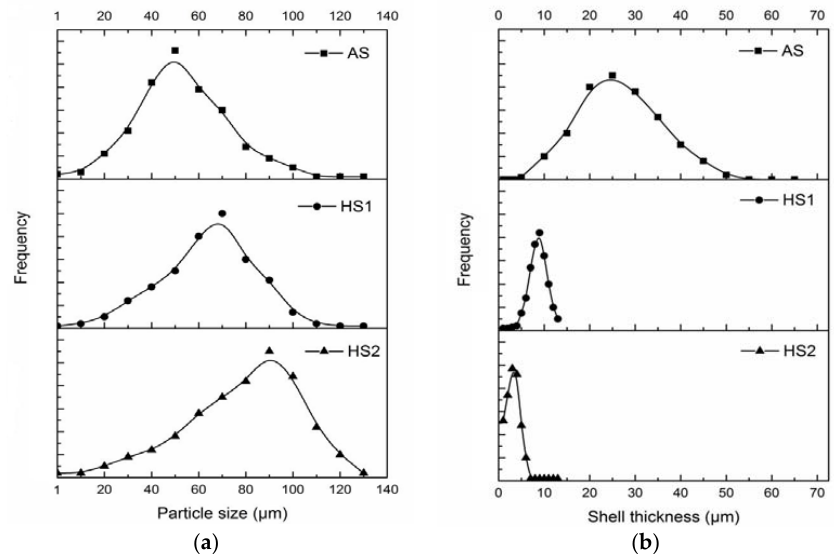
Figure 4. Particle size and shell thickness of three powders: ( a ) particle size of AS, HS1, and HS2; ( b ) shell thickness of AS, HS1, and HS2. (* Statistics by SEM images, and the shell thickness of the AS powder was taken as the radius of the powder since this powder is of an apparently dense structure with no large pore).